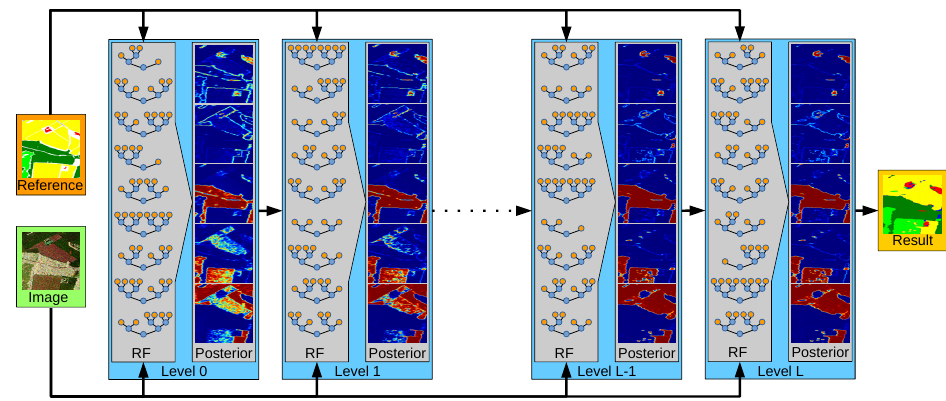
Figure 2. The proposed stacking framework trains an RF at level 0 based on the image data and the reference data, while subsequent RFs use the estimated class posterior as additional feature. This allows a continuous refinement of the class decision and thus leads to more accurate semantic